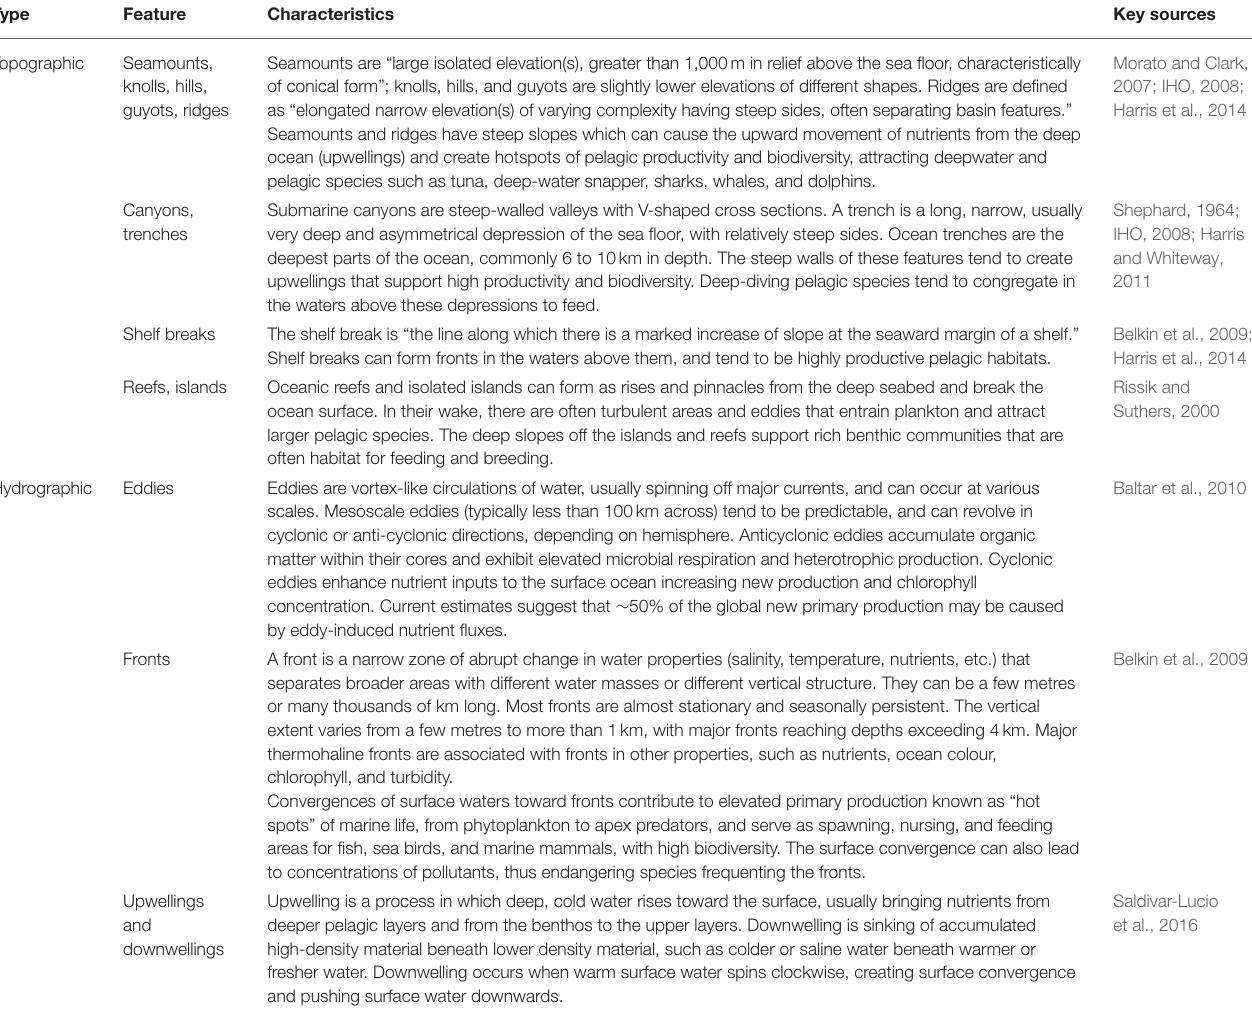
TABLE 4 | Some potential topographically or hydrographically unique, special or rare features of the open ocean.